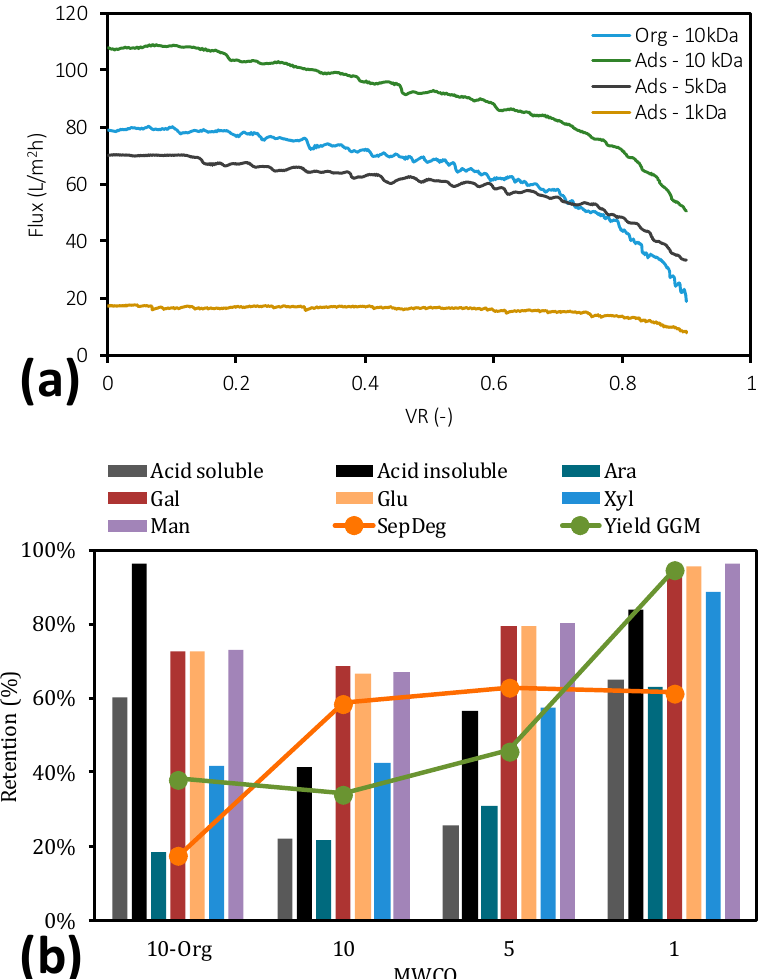
Figure 5. Flux vs. volume reduction (VR) during the ultrafiltration of treated and non-treated SSL ( a ). Retention of solutes during the ultrafiltration studies ( b ).